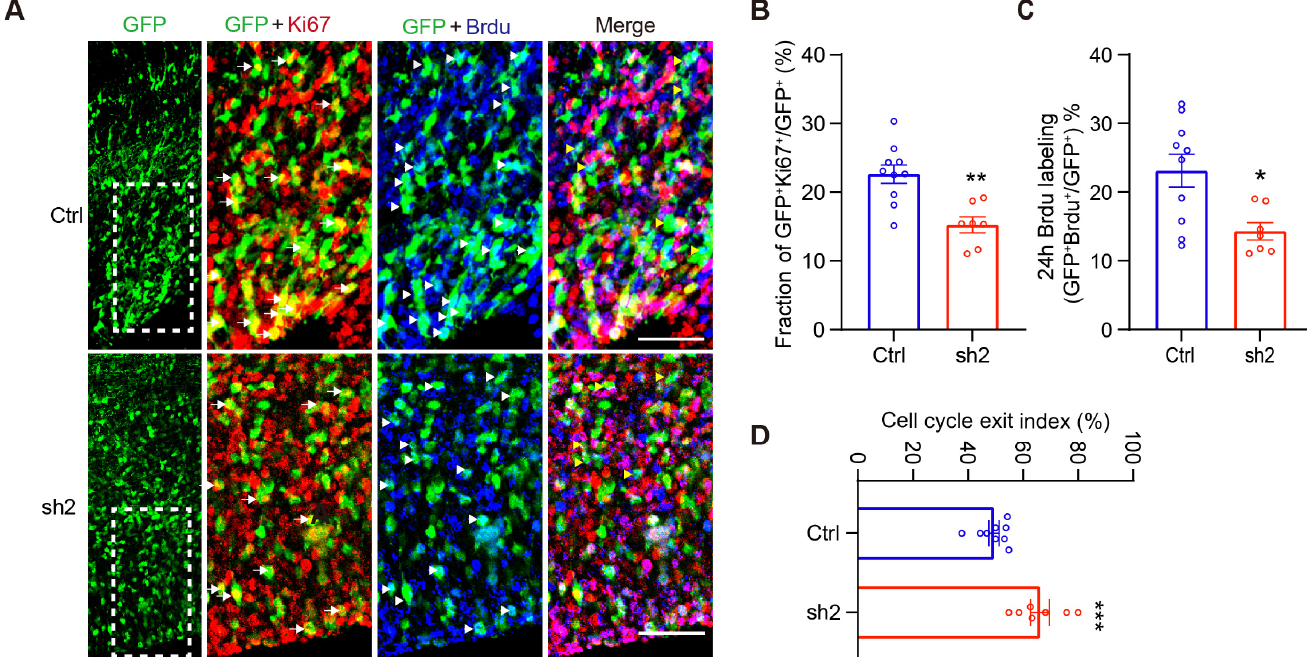
Figure 4. CDC25C is essential for cell cycle regulation. ( A ) Images of the cortices electroporated with Ctrl and Cdc25c sh2 at E15.5 and stained for GFP, Ki67, and BrdU at E18.5 (24 h after BrdU labeling). White arrows indicate GFP and Ki67 double-positive cells, white arrowheads indicate GFP and BrdU double-positive cells. Yellow arrowheads indicate GFP and BrdU positive (BrdU +) but Ki67 negative (Ki67 - ) cells. Scale bars, 50 μ m. ( B ) Quantification Ki67 + cells in GFP + population. Data are mean ± SEM, ** p < 0.01, unpaired t-test. ( C ) Quantification BrdU + cells in GFP + population. Data are mean ± SEM. * p < 0.05, unpaired t-test. ( D ) Cell-cycle exit index measured by (BrdU + Ki67 − )/ BrdU + . Data are mean ± SEM. *** p < 0.001, unpaired t-test. (B–D) Individual data showed brain slice number from Ctrl, n = 4 and sh2, n = 4 independent mice.